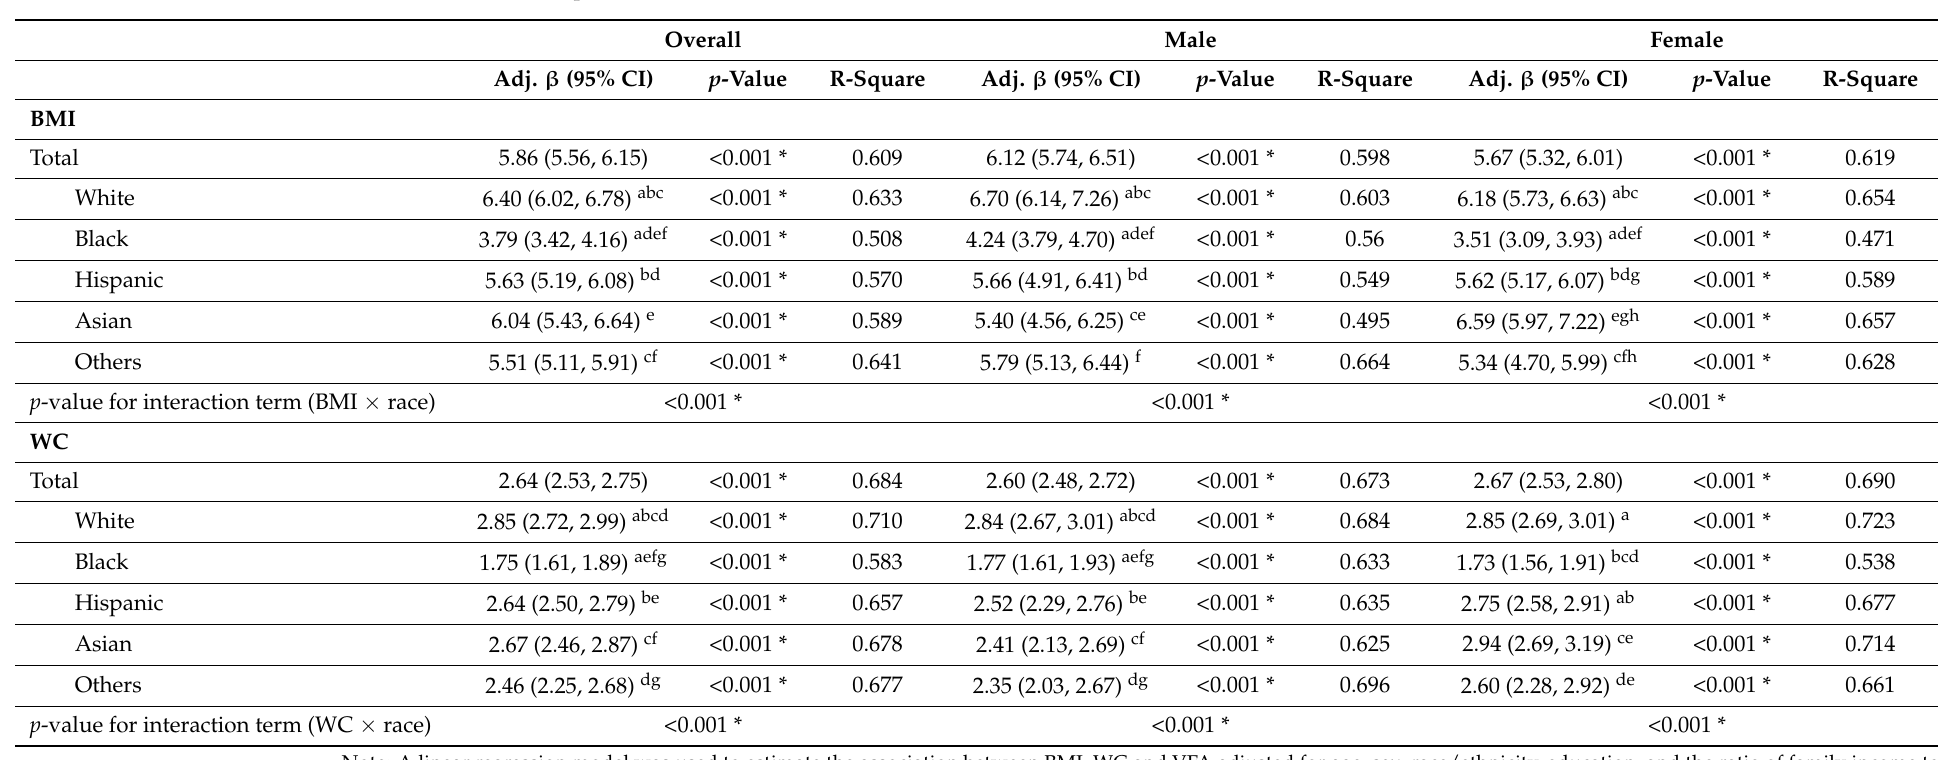
Table 2. The relationships between BMI, WC and VFA (cm 2